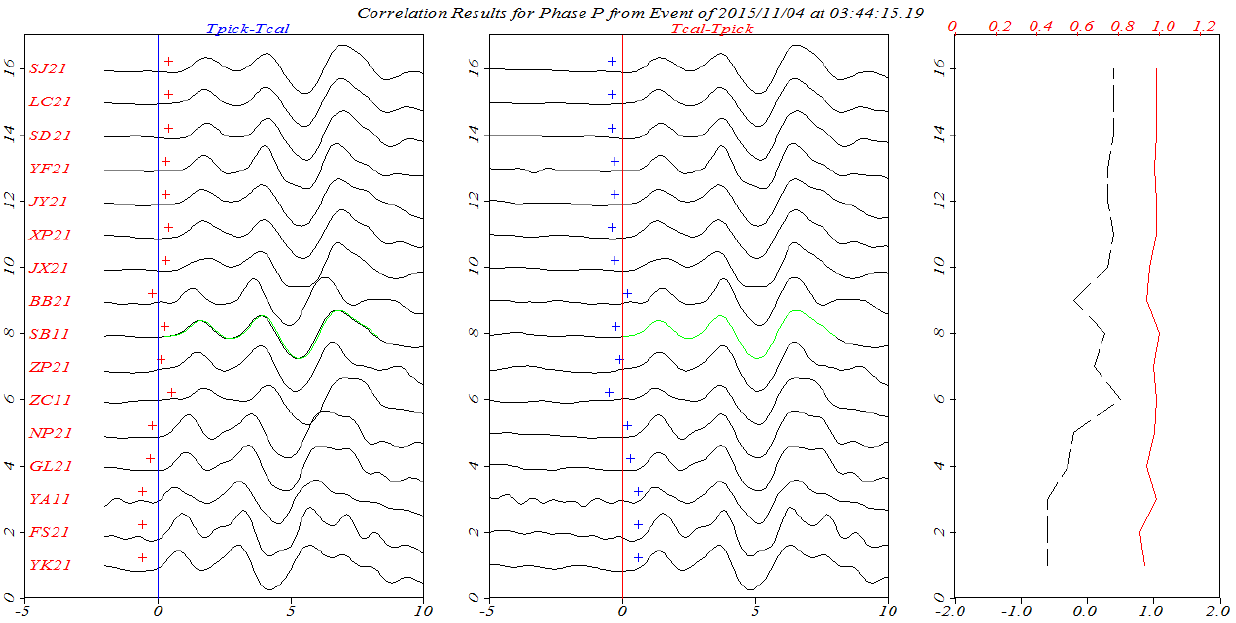
Figure 8. Cross-correlation results of Brazilian earthquake records. Figures 9 and 10 show the cross-correlation effects, and the correlation coefficients are used to further assess the accuracy of the seismic phase travel time picking.